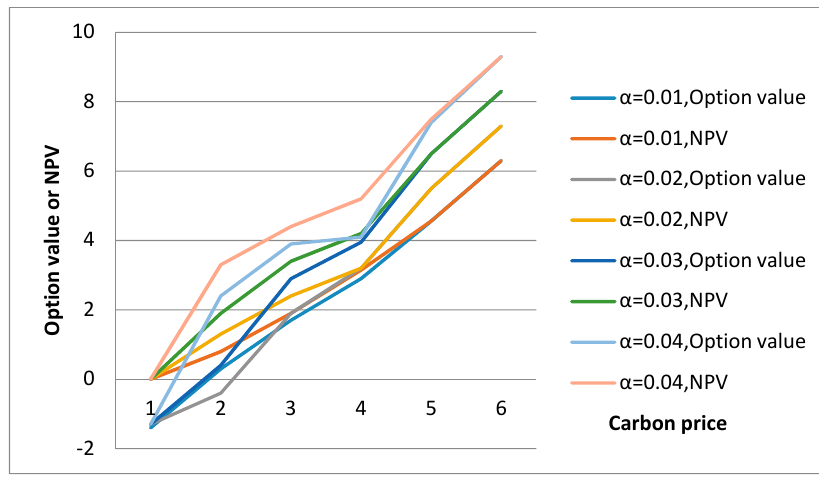
Figure 2. The relationship between F, Net Present Value and α.